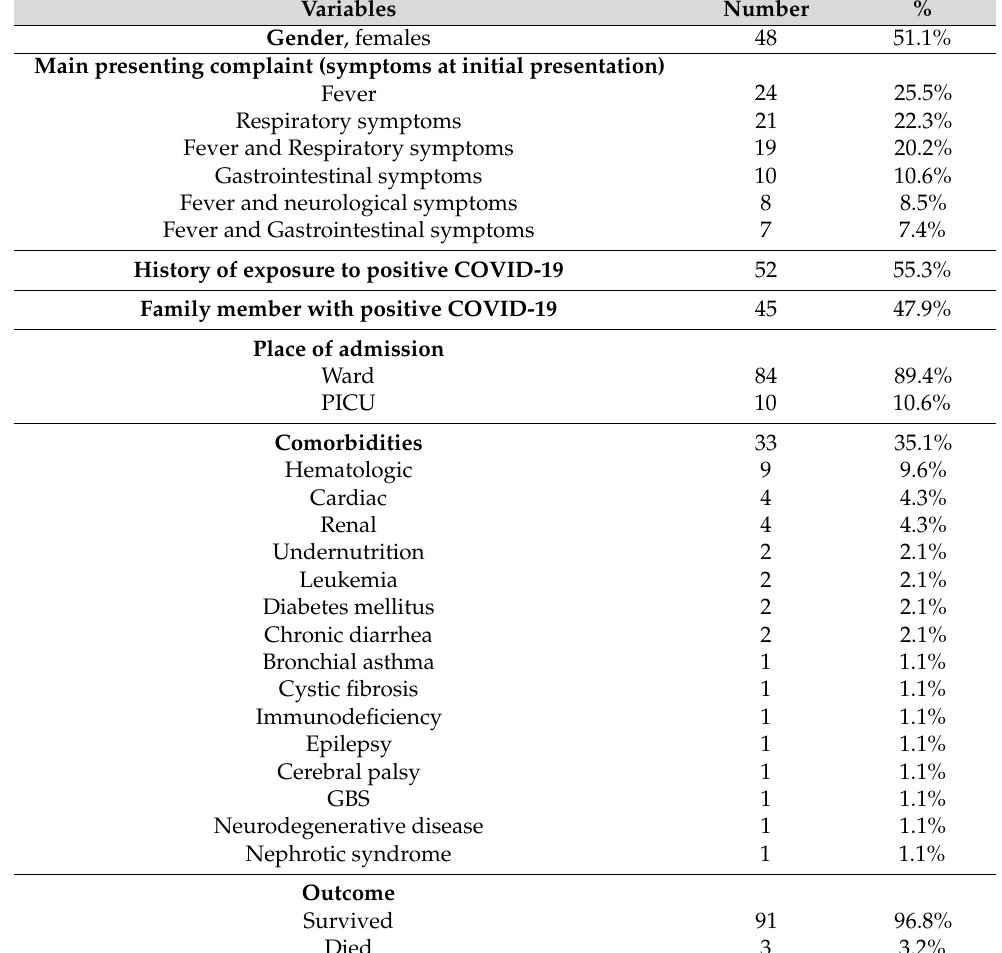
Table 1. Demographic and clinical characteristics of the whole studied group (N = 94).